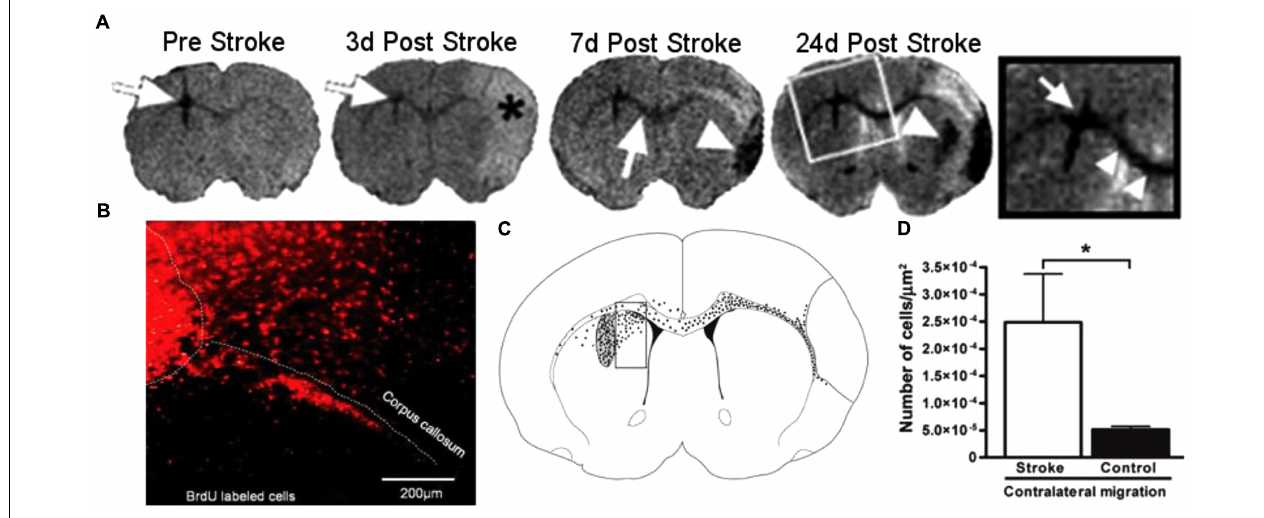
FIGURE 4 | Magnetic resonance imaging (MRI) of NPCs migrating to stroke (Guzman et al., 2008, reproduced with permission). The top panel (A) shows a representative MRI of animals injected with NPCs before and over 24 days after the induction of stroke. White arrows show the location of labeled cells, moving from the site of injection to the area of stroke, denoted with an asterisk ( ∗ ). The bottom panel (B–D) shows the histology of animals 24 days after stroke. Cells labeled with BrdU (red, B ) were observed migrating away from the site of injection and into the corpus callosum. To quantify the migration, the area adjacent to the injection site was analyzed by counting cells in a counting box (C) . The graph shows significantly greater migration away from the injection site in animals that received a stroke than the sham controls. Reproduced with permission.